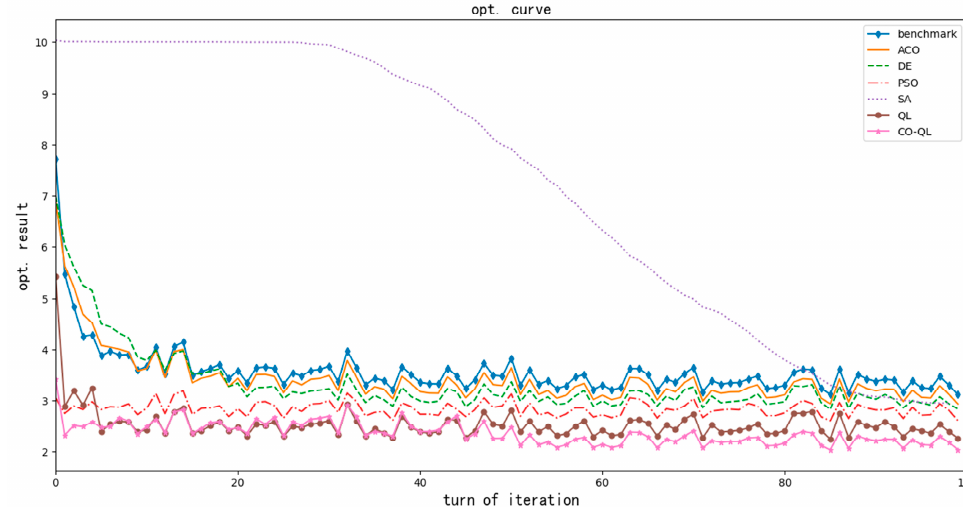
Figure 5. Comparison of convergence speed of algorithms.